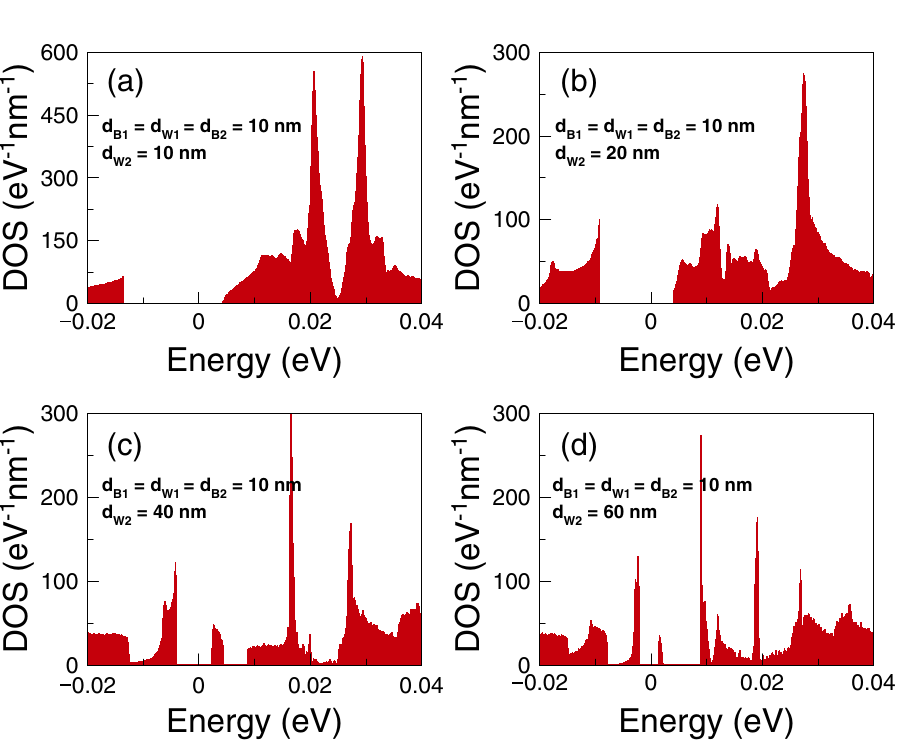
Figure 22. The same as Fig. 15, but for d B = d W = 10 nm. Here, the width of the second well takes the values: ( a ) d W 2 = 10 nm, ( b ) d W 2 = 20 nm, ( c ) d W 2 = 40 nm and ( d ) d W 2 = 60 nm. As d W 2 increases the electron states accumulate in the Breit–Wigner and hybrid resonances energy